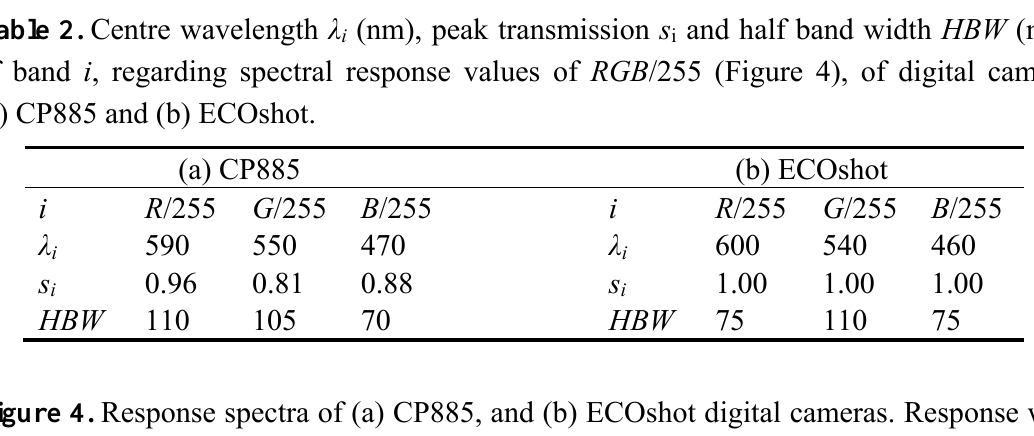
(nm), peak transmission s and half band width HBW (nm) i i